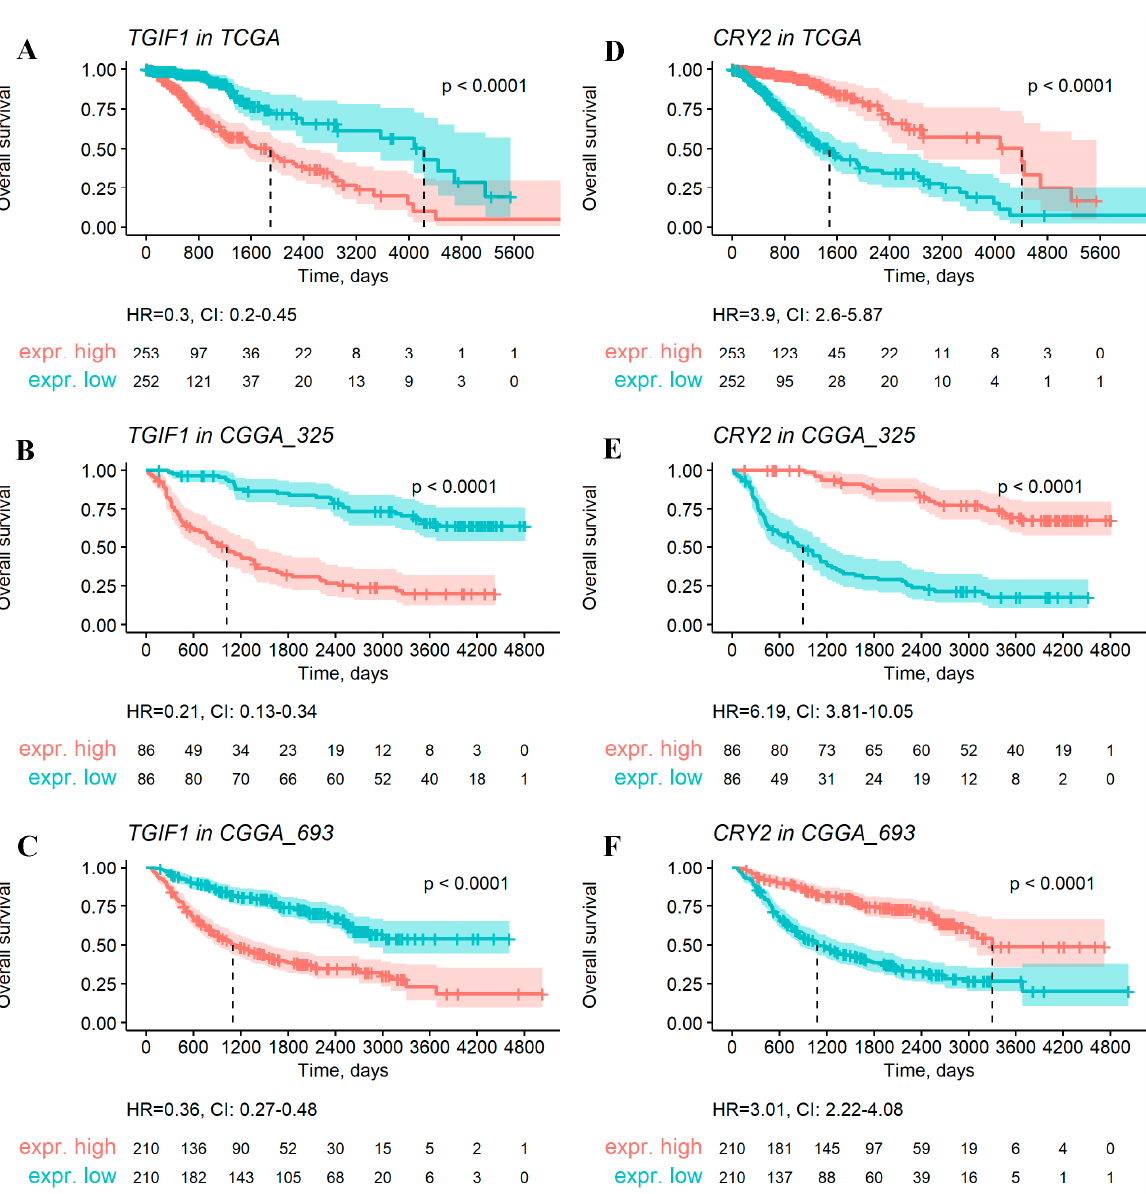
Figure 4. Examples of the negative ( TGIF1 gene, panels ( A – C )) and positive ( CRY2 gene, panels ( D – F )) overall survival gene expression biomarkers identified using a systematic statistical approach on LGG data from TCGA ( A , D ), CGGA_325 ( B , E ), and CGGA_693 ( C , F ) datasets. “High” and “low” levels were defined relative to a median gene expression value. Hazard ratio (HR) and its confidence interval (CI) is shown for every analysis.